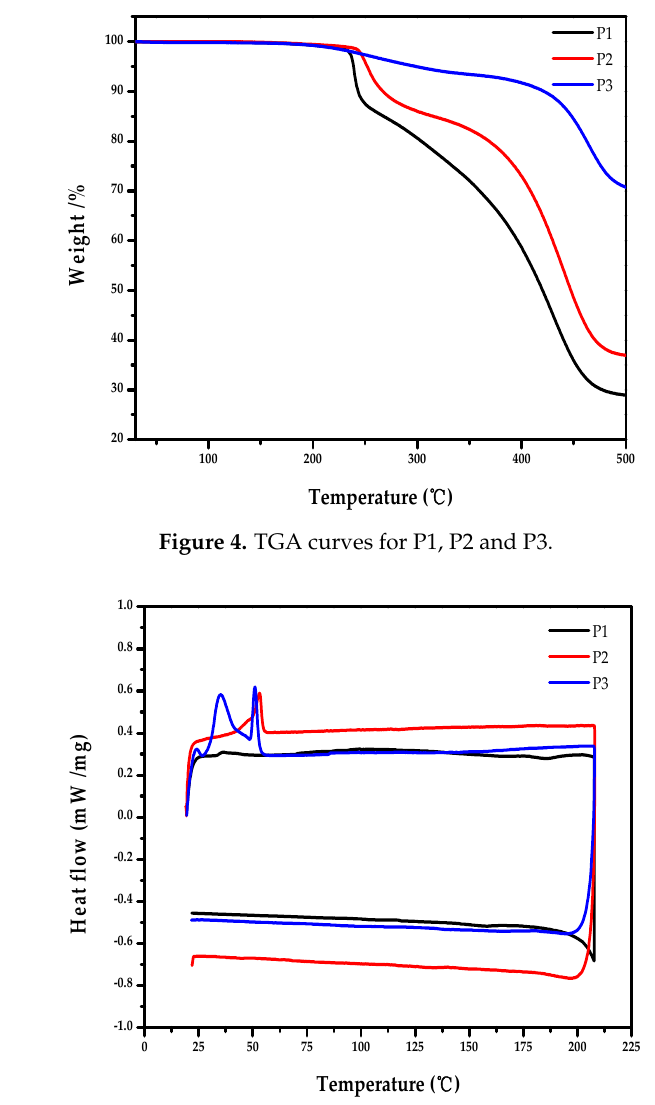
Figure 5. DSC curves for P1, P2 and P3.